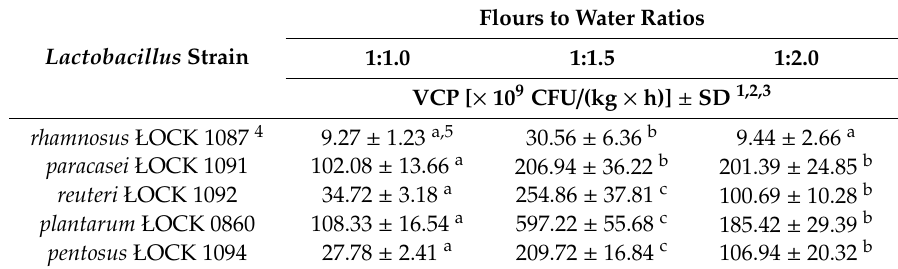
Table 2. Viable cells productivity of selected Lactobacillus strains cultivated in SSF mediums with di ff erent water